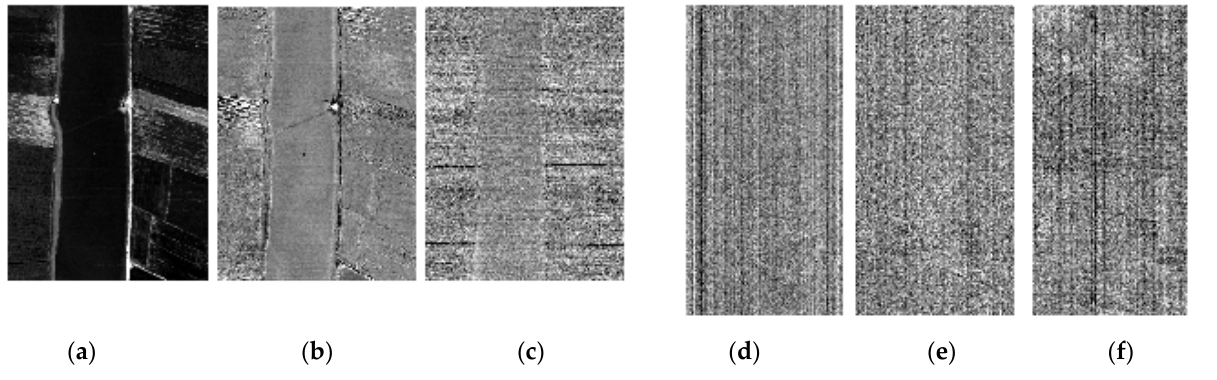
Figure 6. ( a – c ) The MNF transform at 19 bands, ICA transform at 19 bands, and PCA transform at 13 bands, respectively, in the Longkou area; ( d – f ) the MNF transform at 19 bands, ICA transform at 45 bands, and PCA transform at 9 bands, respectively, in the Honghu area.